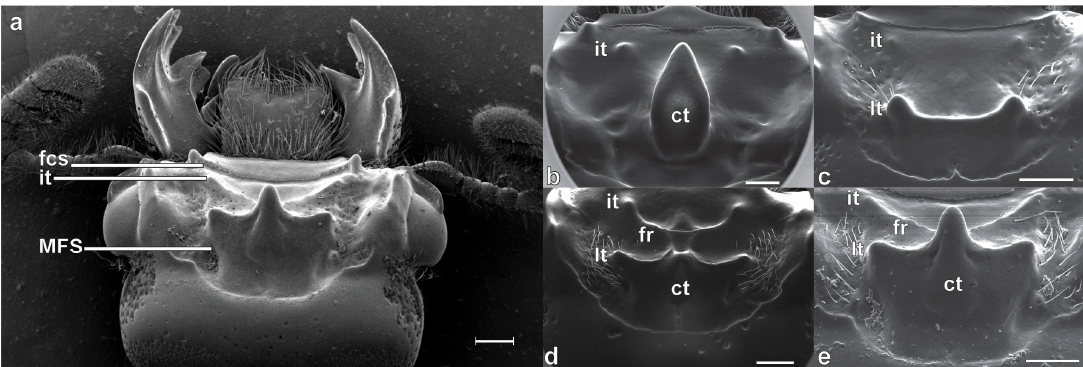
Figure 1. Scanning electron micrographs of mesofrontal structures of selected Passalidae, dorsal view. ( a ) Head capsule of Yumtaax recticornis (Burmeister, 1847), for context. ( b ) The “ striatopunctatus ” type; Odontotaenius striatopunctatus (Percheron, 1835). ( c ) The “ bicornis ” type; Spurius bicornis (Truqui, 1857). ( d ) The “ marginatus ” type; Popilius sp. ( e ) The “ falsus ” type; Y. recticornis , detail of ( a ). Abbreviation list, fcs = frontoclypeal suture, it = internal tubercles, MFS = mesofrontal structure [5], ct = central tubercle, lt = lateral tubercles [5], latero-posterior tubercles [1], fr = frontal ridges [5], postero-frontal ridges [1].